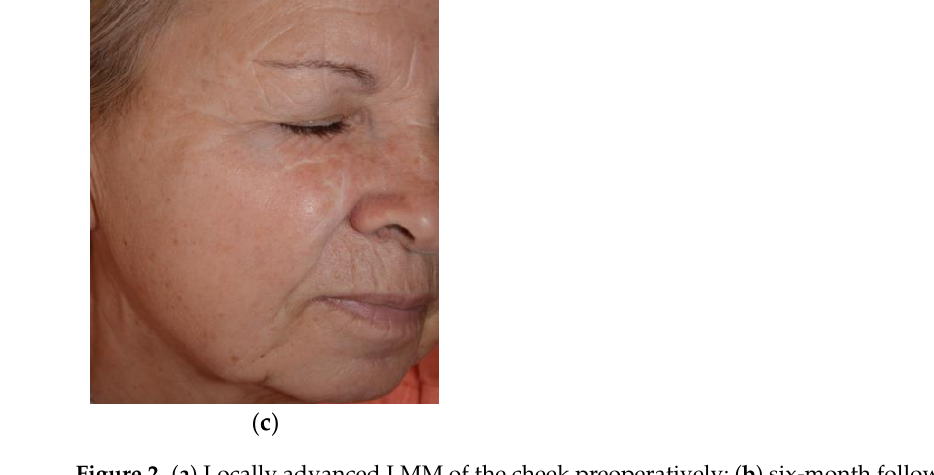
Figure 2. ( a ) Locally advanced LMM of the cheek preoperatively; ( b ) six-month follow up; ( c ) five- year follow-up. In Patients 2 and 3, large cervicofacial flaps were transposed to the defect with exten- sive undermining on the neck and secured to the zygomatic bone by periosteal anchoring (see Figure 3).